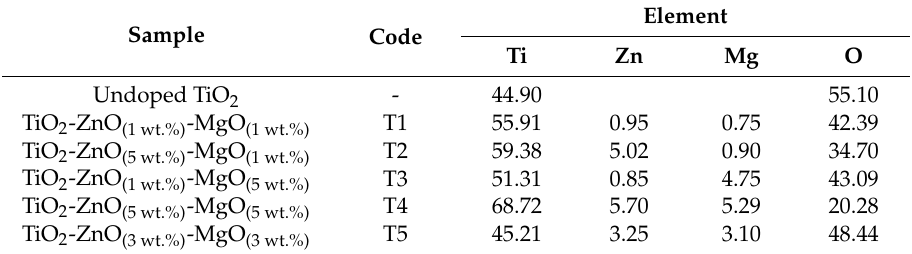
Table 1. Energy dispersive spectroscopy results of the composition (wt.%) obtained from the materials.